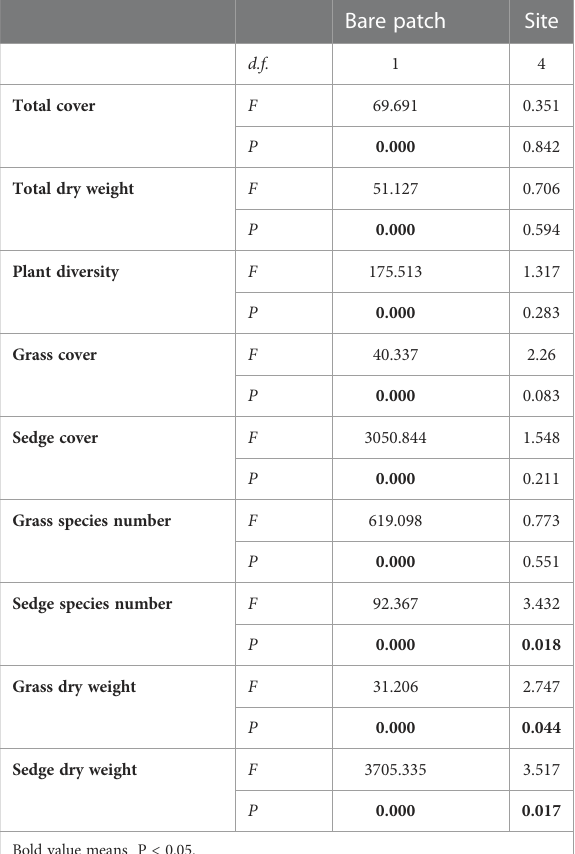
TABLE 2 Effects of bare patches resulting from plateau pika burrowing activity and sites on plant community as analysed by a mixed-effect ANOVA.